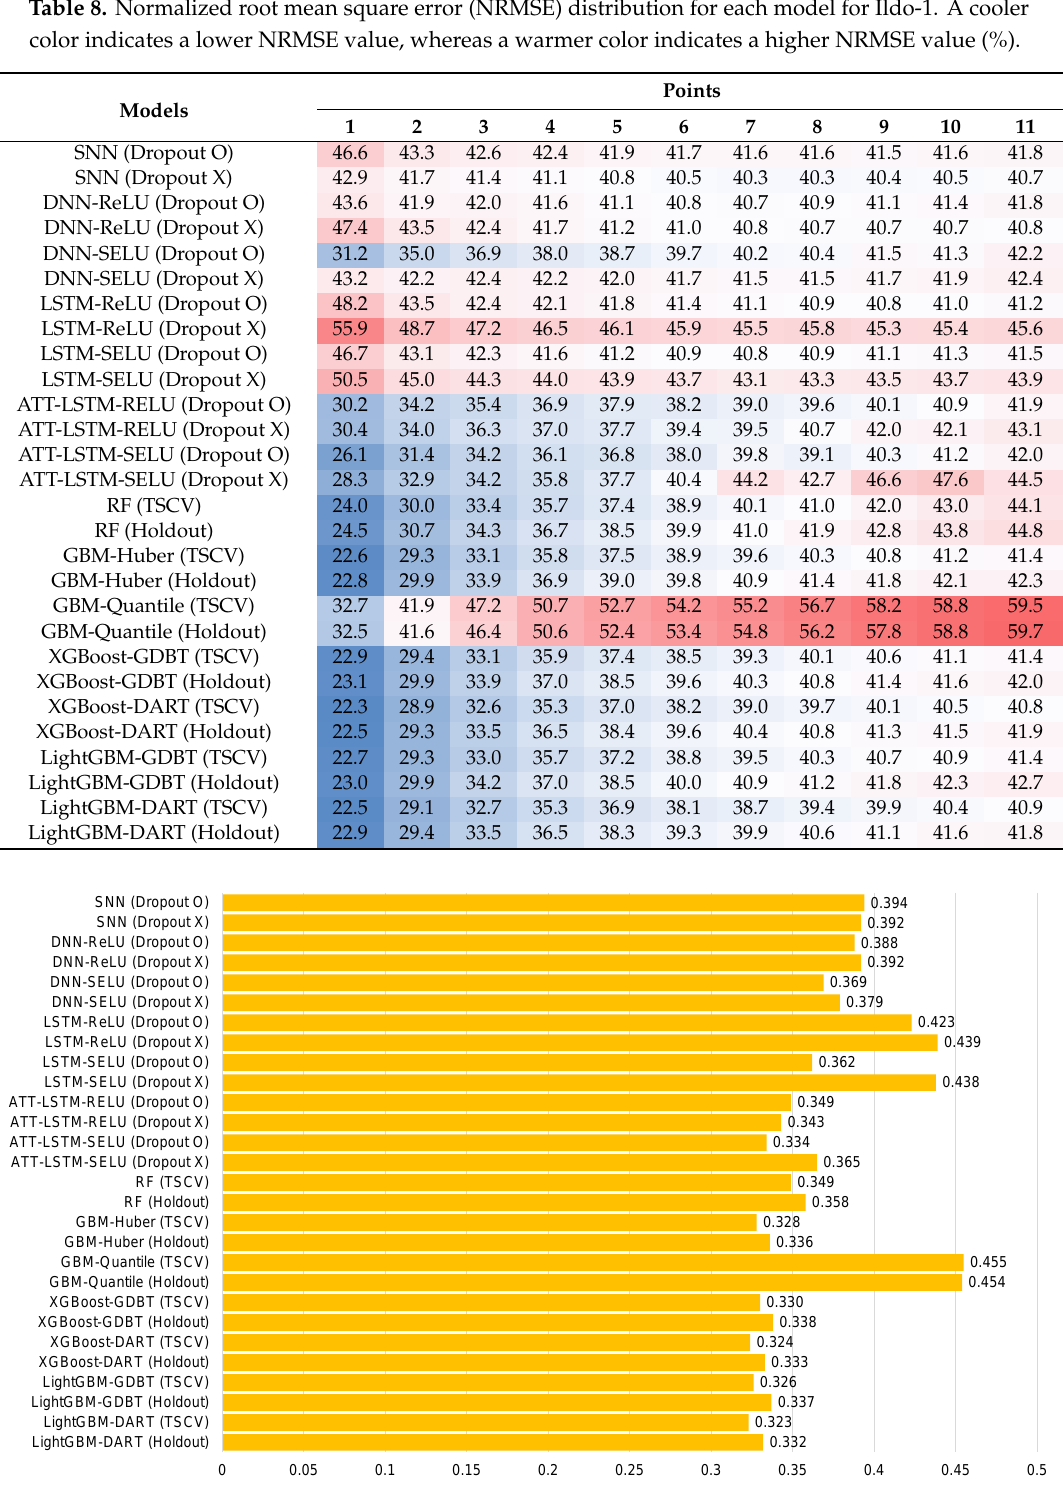
Figure 7. Average mean absolute error for each model of Ildo-1 ( MJ/m ).